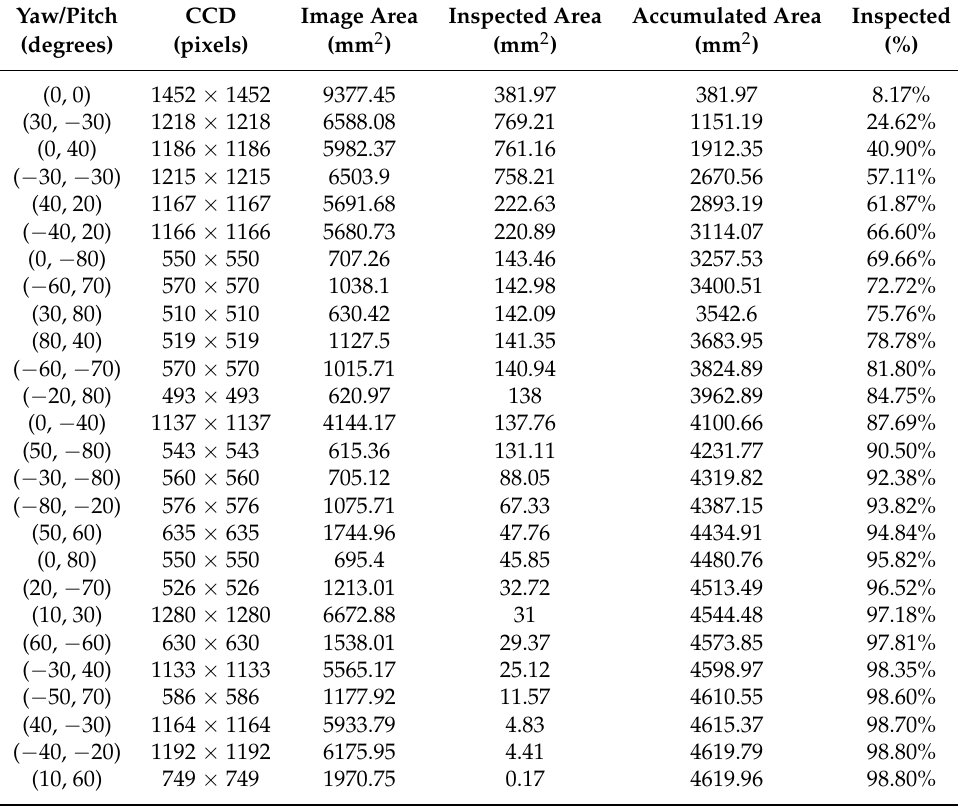
Table 4. Environment and camera characteristics to acquire 26 images needed to inspect the metallic logo using the reference lighting.